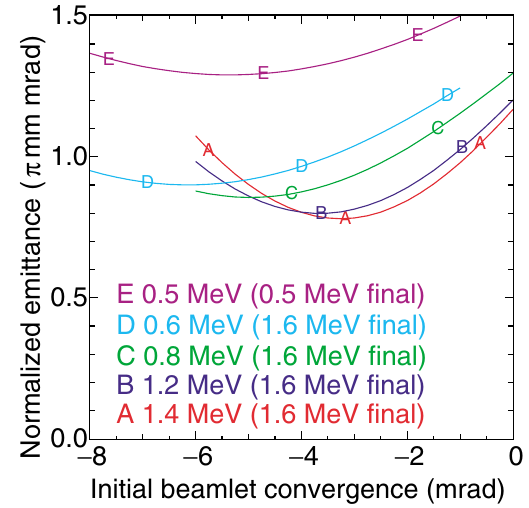
FIG. 5. (Color) Results from 2D slice simulations; emittance is shown versus the initial beamlet convergence angle. Compares cases with differing merging energies, for 91 beamlets and (cid:2) 0 : 5 mm . clearance r c